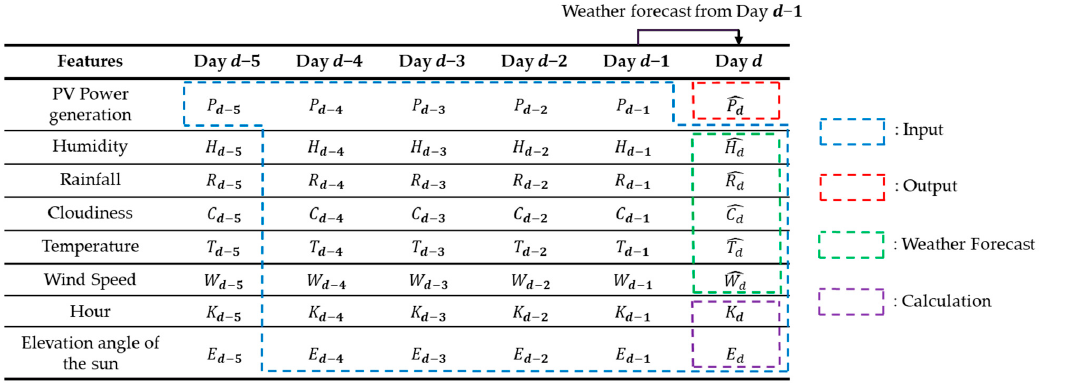
Figure 4. Inputs and outputs at the testing phase .